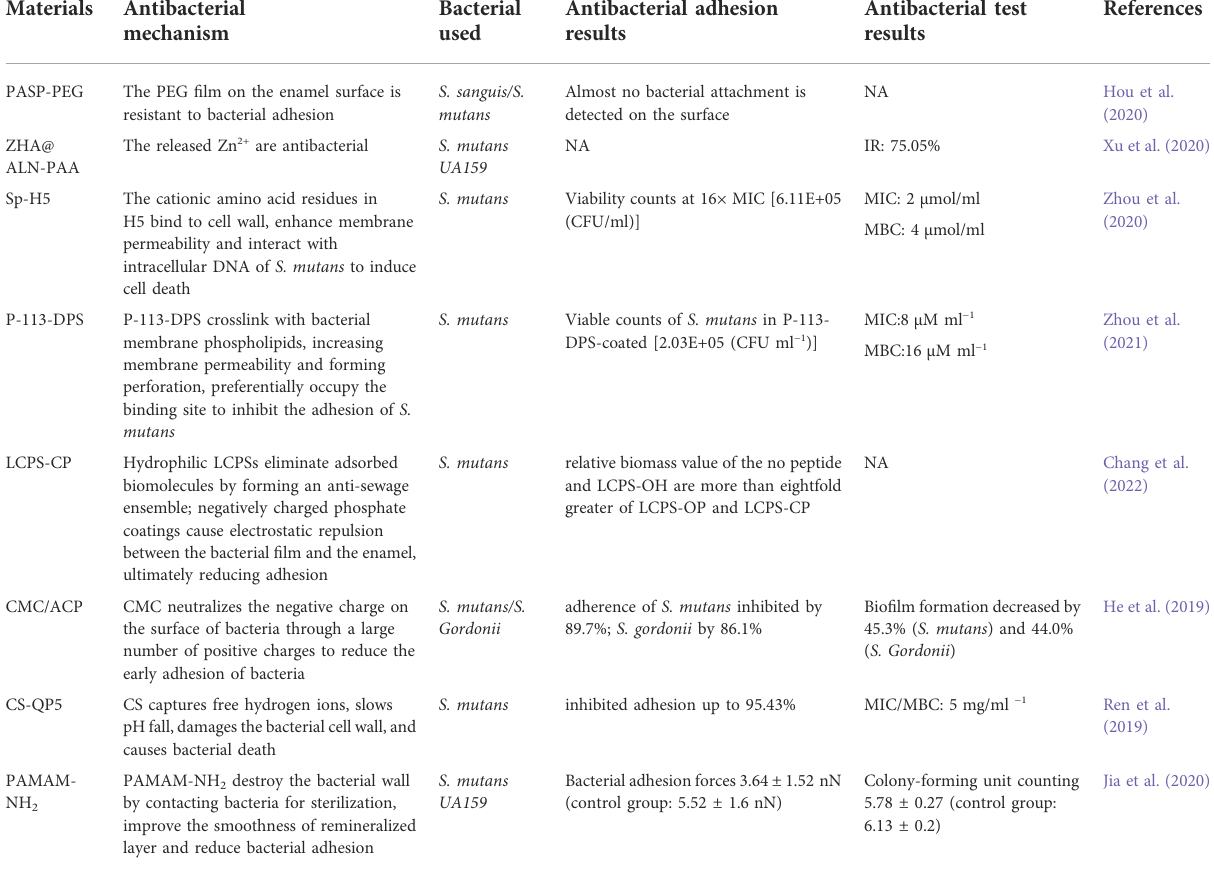
TABLE 2 Antibacterial remineralization dual